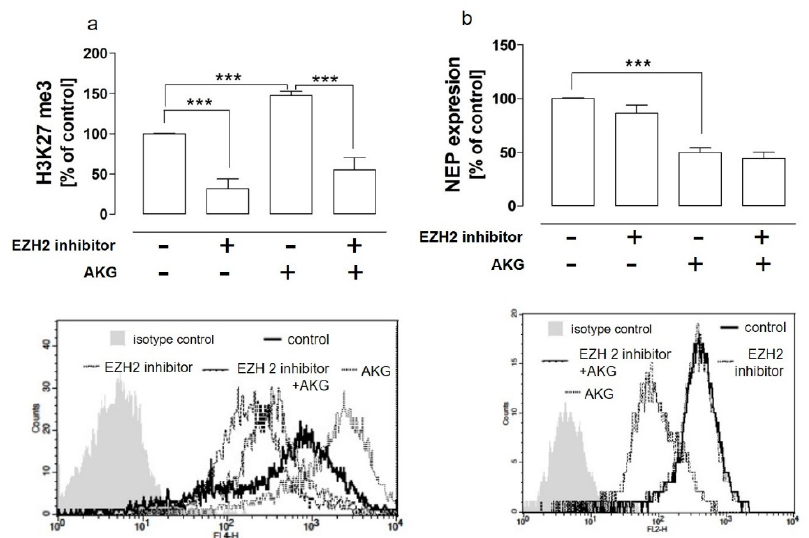
Figure 4. The enhancer of zeste homolog 2 (EZH2) methyltransferase was partially implicated in the AKG-induced hypermethylation of lysine 27 but not in the downregulation of NEP in the osteosarcoma cells. The HOS cells were treated with AKG (50 mM) and/or the EZH2 inhibitor EPZ005687 (10 µ M) for 72 h. The me3 modification of histone H3 at lysine 27 ( a ) and NEP expression ( b ) were detected as described in Figures 2 and 3, respectively. The histograms are representative and correspond with the results presented in the graphs. The results were expressed as a percent of the control (0 mM) ± SD of three independent experiments. Statistically significant differences: *** p < 0.001, in comparison with the control cells or with the AKG-treated cells (one-way ANOVA followed by Tukey’s post-hoc test).